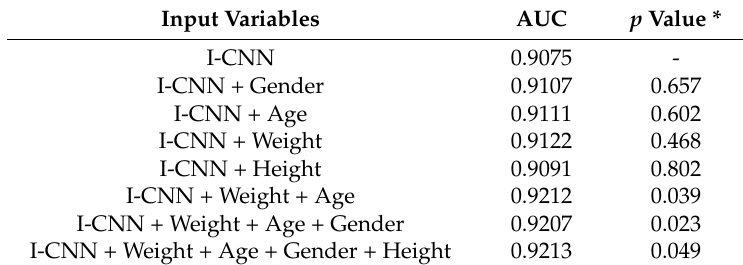
Table 3. AUC comparison of various demographic variable combinations for the training dataset: in reference to convolutional neural networks using I-CNN.